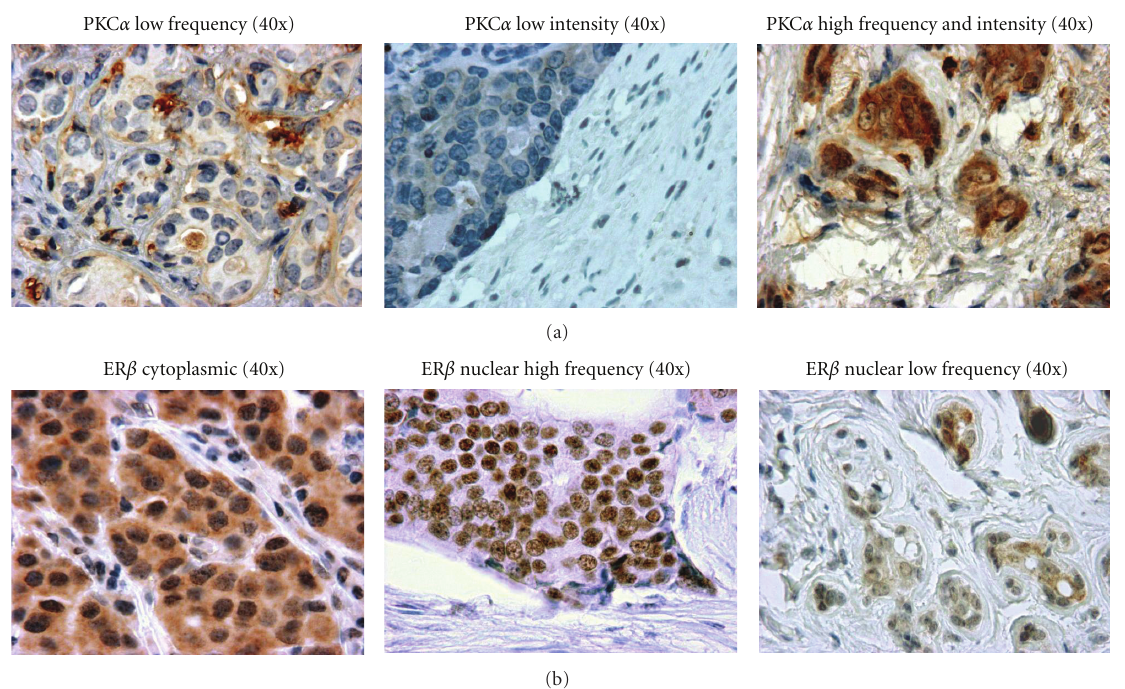
Figure 1: (a) Expression of PKC α (brown immunoperoxidase stain, blue hematoxylin counterstain). (b) Expression of ER β (brown immunoperoxidase stain, blue hematoxylin counterstain).